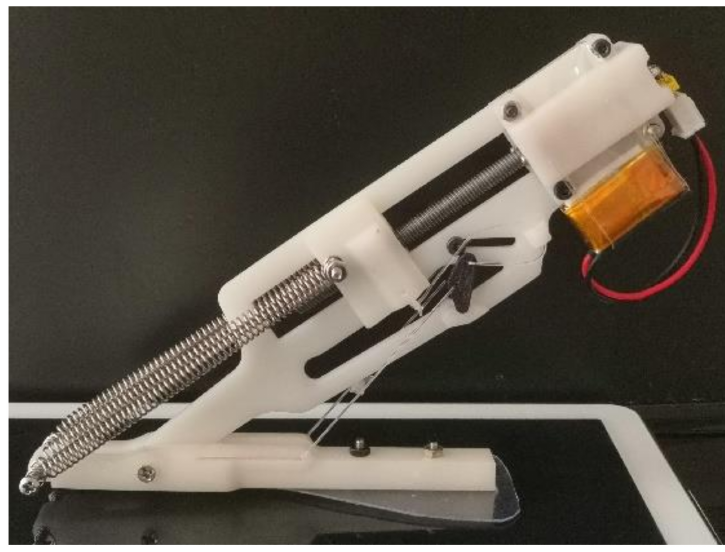
Figure 11. Physical